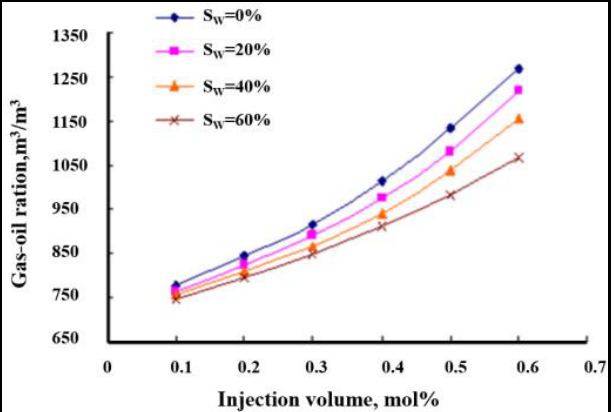
Figure 14. The relationship between saturation pressure and CO 2 injection molar quantity at different water content.